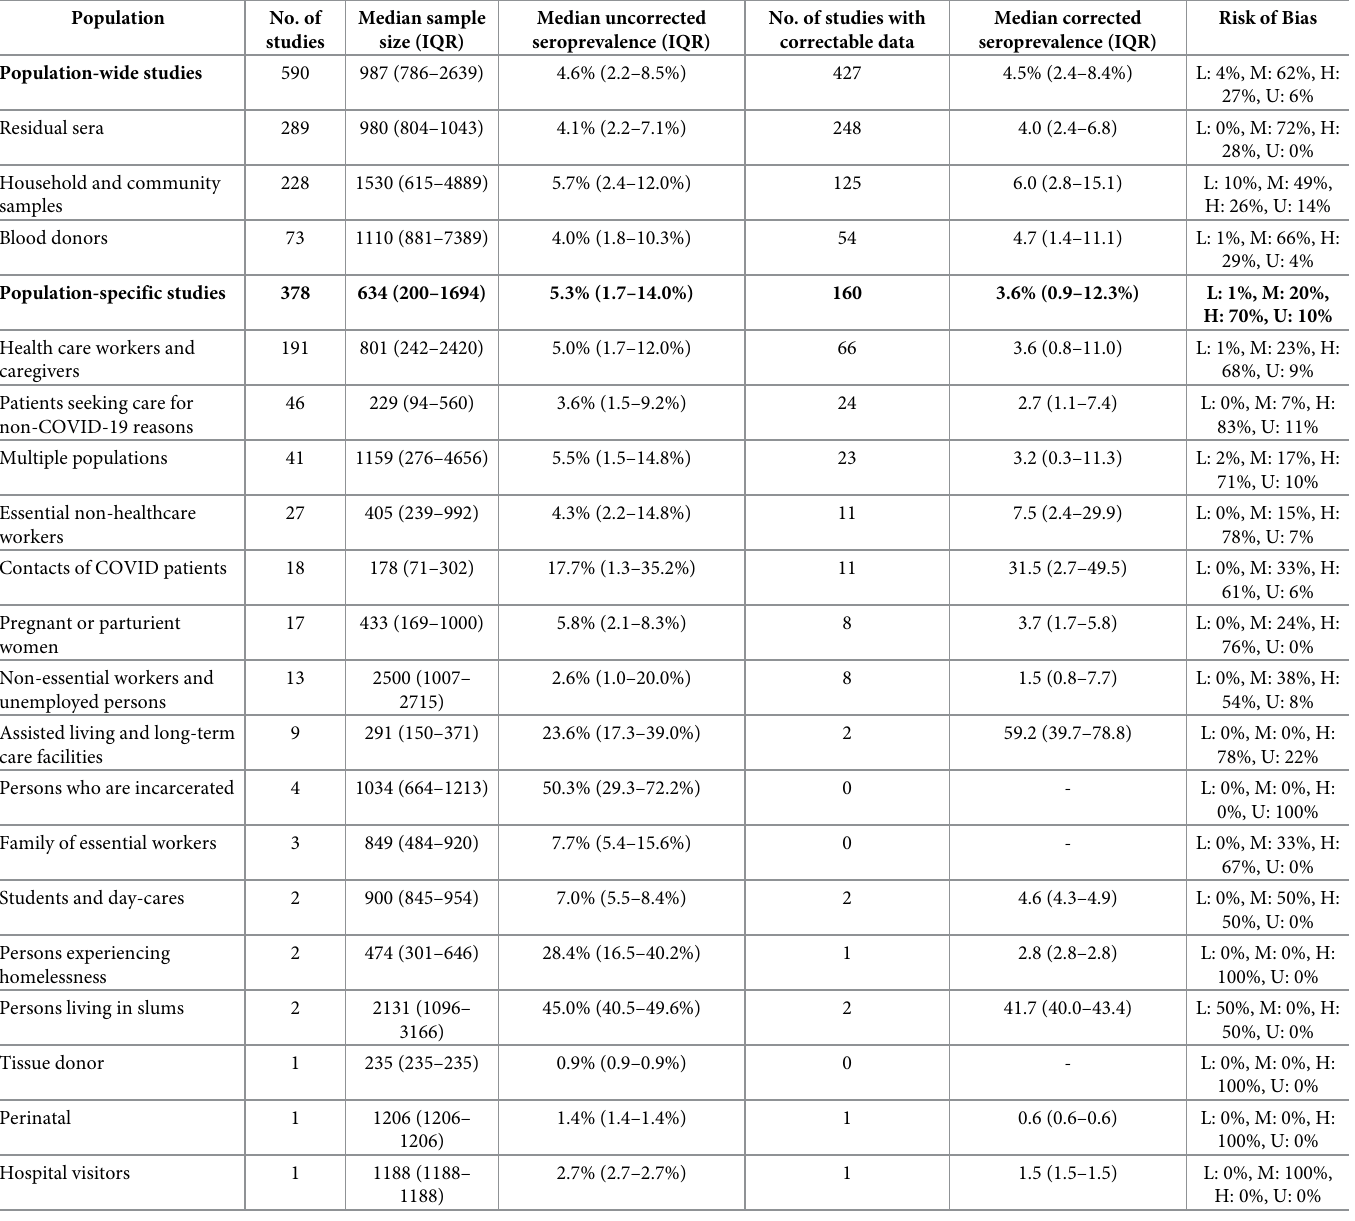
Table 3. Summary of seroprevalence data by study sampling